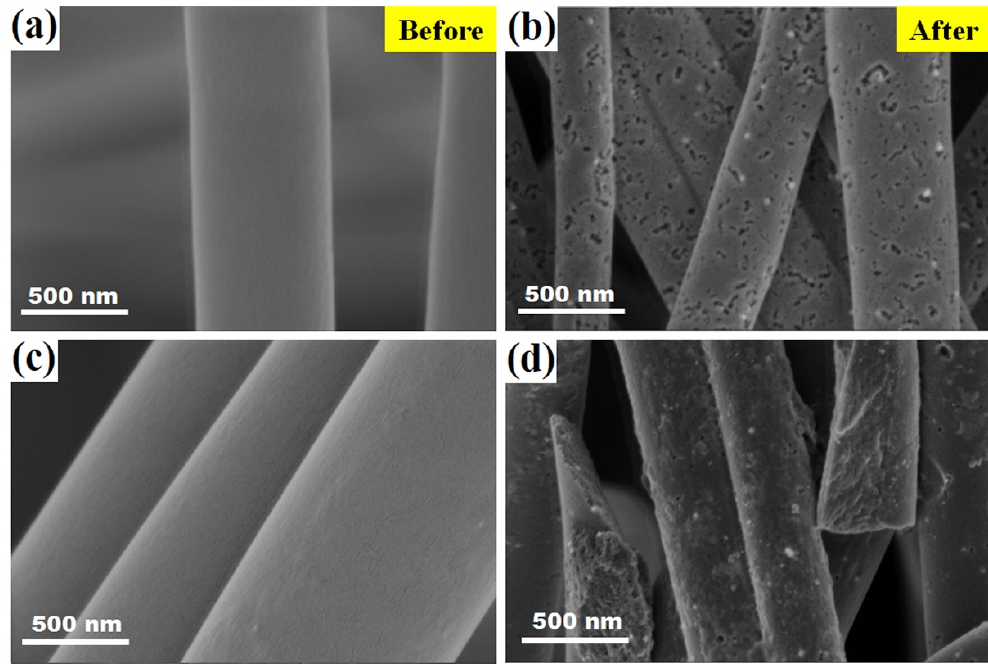
Figure 4. SEM images of MWCNT filled carbon nanofiber mats with different contents of MWCNT before and after carbonization. ( a , c ) PVA nanofibers mats with 0.05 and 0.1 wt.% MWCNT and ( b , d ) CNF mats filled with 0.05 and 0.1 wt.% MWCNT, respectively.